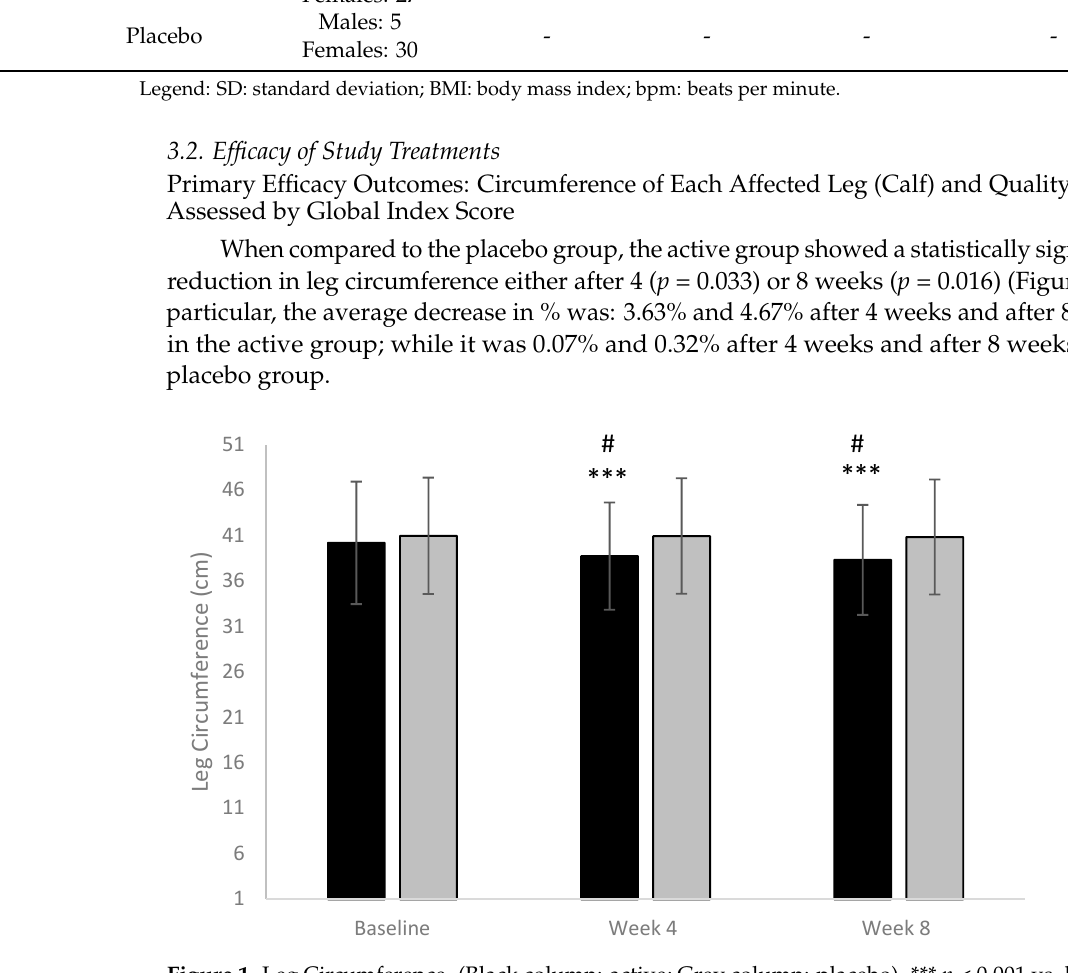
Figure 1. Leg Circumference. (Black column: active; Grey column: placebo). *** p < 0.001 vs. baseline; # p < 0.05 active vs.